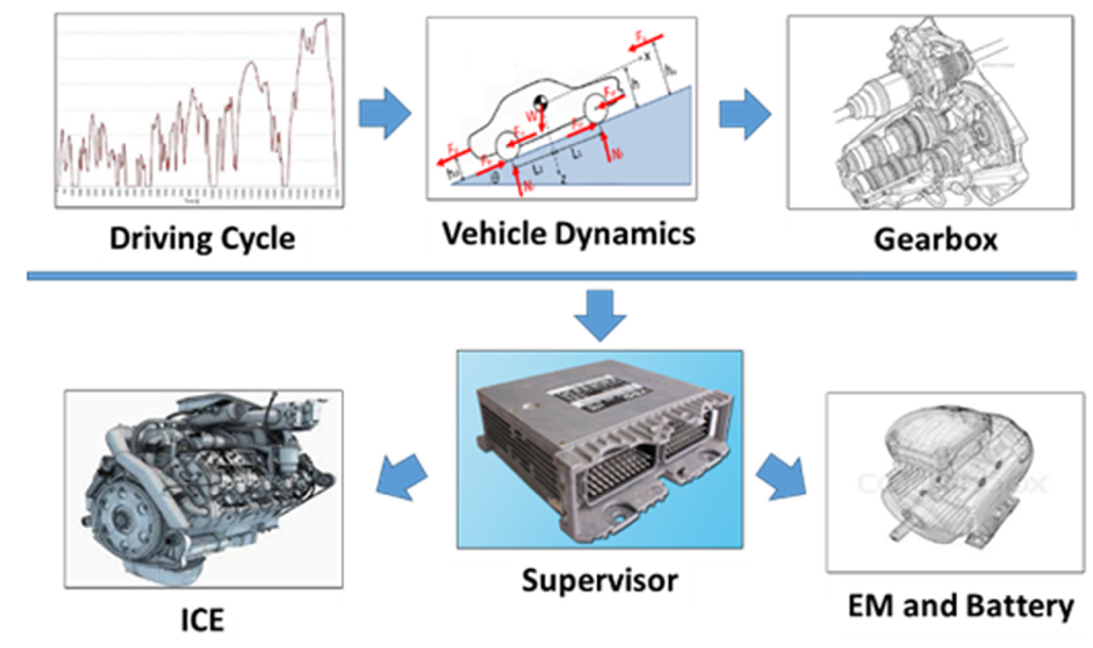
Figure 1. Overview of the HEV simulation tool.